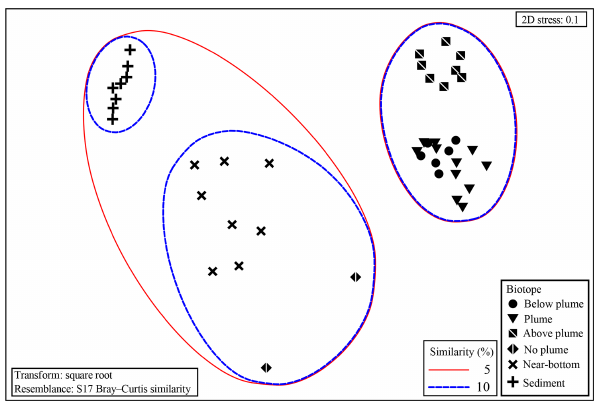
Figure 8. Non-metric multidimensional scaling plot of the micro- bial community composition of all samples based on Operational Taxonomic units. Similarity groupings are based on group average clustering. “No plume” is representative of samples collected from station 13, where there was no indication of a